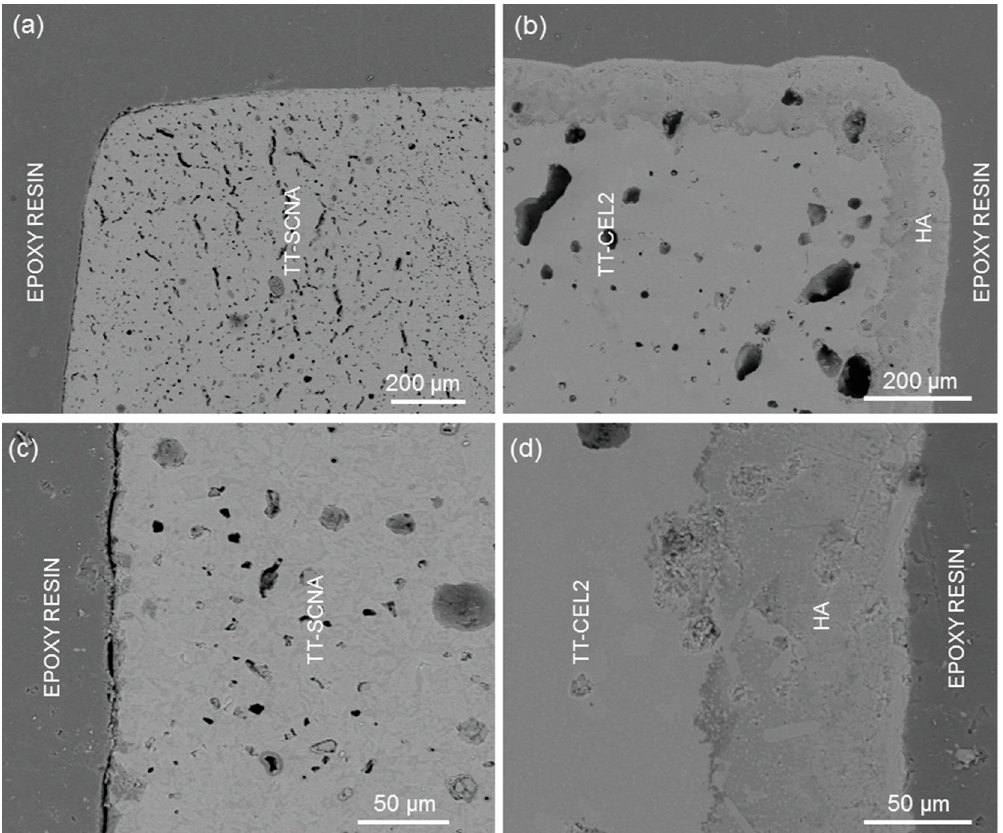
Figure 9. Cross-sections of a bilayered implant after soaking for one month in SBF at different magnifications: ( a , c ) TT-SCNA region and ( b , d ) TT-CEL2 region.